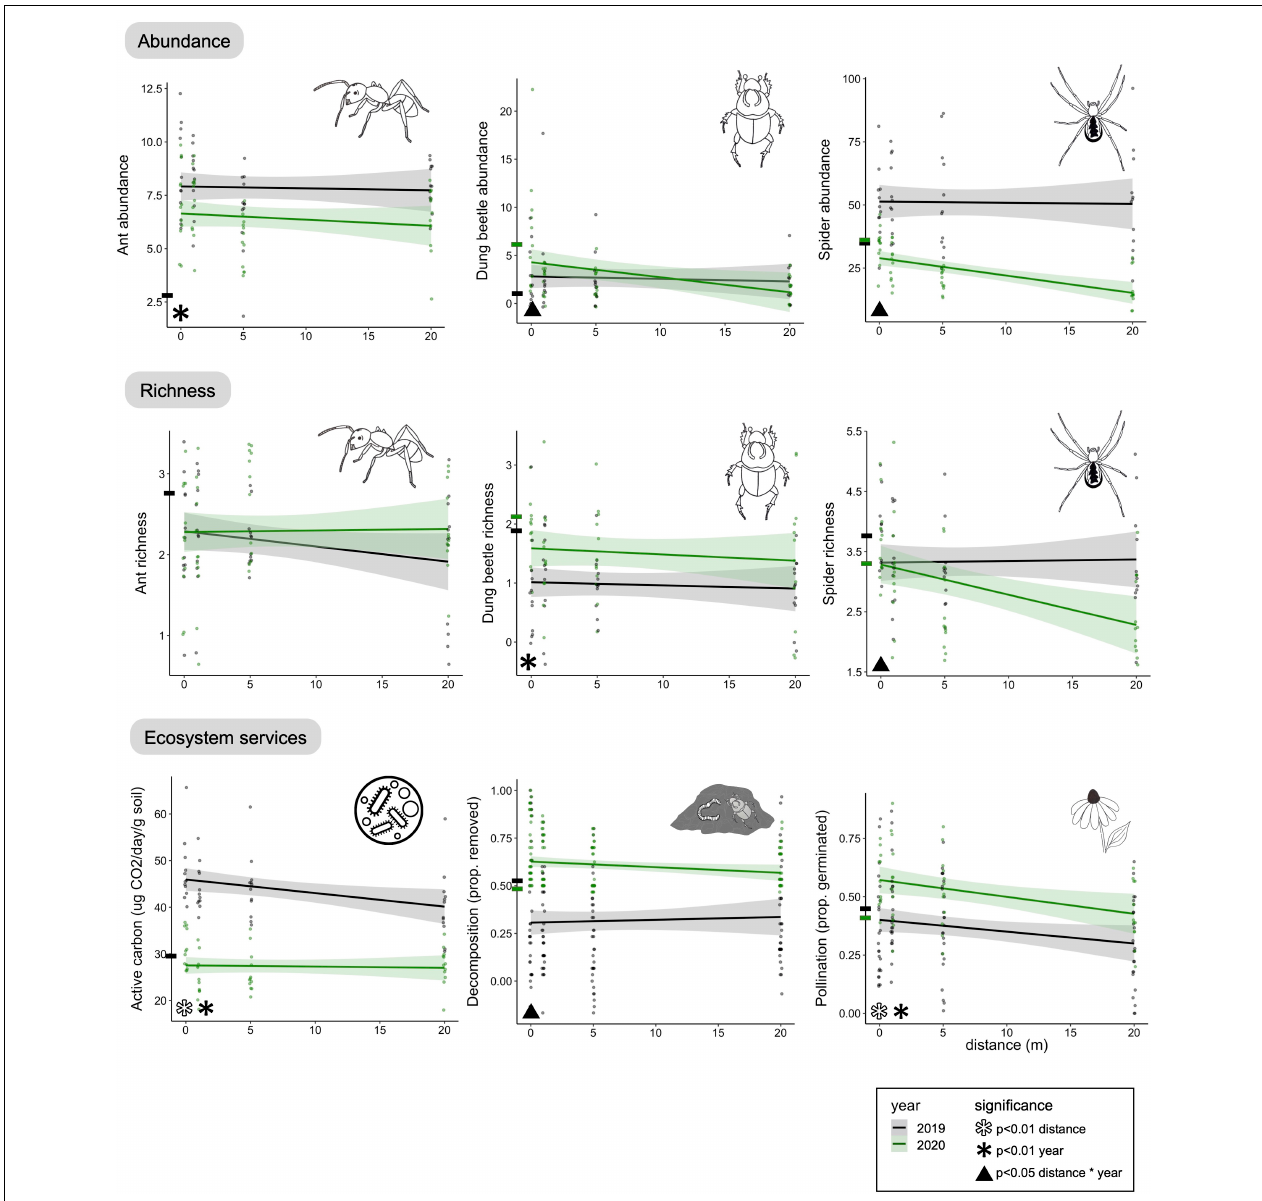
FIGURE 4 | Effects of distance from prairie strips on measures of biodiversity and ecosystem services in both reduced input and biologically based treatments. We considered linear effects of distance from prairie strips. The interaction with year is presented, with 2019 being the first year of prairie strip implementation and a wheat year, and 2020 being the second year and a maize year. Distance 0 m is within the prairie strip. Black dashes on the y-axis represent the mean of the plot level values for reduced input and biologically based for that measure in 2019; green dashes represent 2020. Ant data from 2019 is modified from Helms et al. (2021).